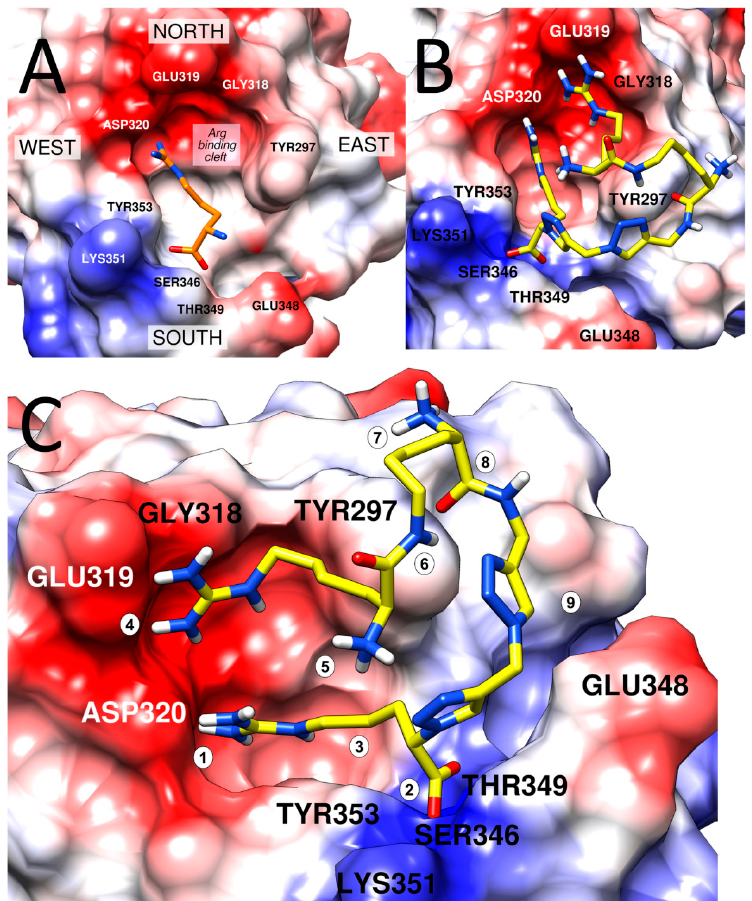
Figure 7. Binding site at the neuropilin-1. The protein is depicted as an electrostatic colour-coded surface (red: negative charges, white: neutral, blue: positive). ( A ) The binding site presented with the conventional assignment of directions as introduced in our previous contributions [28–30]. C-terminal arginine residue (orange, found in our inhibitors, but also in VEGF (4DEQ [44]) or tuftsin (2ORZ [43]) or arginine derivatives (5JGI, 5IYY, 5J1X, 5JGQ, 5JHK [45]) is shown in the cleft it occupies in crystal structures as well in simulations. ( B ) Compound 3 (yellow) at the NRP-1 binding site. A representative snapshot from SIM-I showing the discussed binding mode. Top projection. ( C ) Compound 3 (yellow) at the NRP-1 binding site. A representative snapshot from SIM-I showing the discussed binding mode. Rotated top projection. Marked are characteristic elements of the binding mode. 1—ionic interaction of Arg guanidine with Asp320; 2—hydrogen bonds of free carboxylate with Ser346 and Thr349; 3—Arg chain buried within the cleft, extended between Tyr353 and Tyr297, further apolar interactions with Trp301, Thr316, Gly414, Ile415, and Ser416; 4—Har interacts with Glu319 and Gly318; 5—Har free amine exposed to the solvent; 6—H of the amide bond interacts either with phenolic function of Tyr297 or forms an intramolecular hydrogen bond with triazole ring (N3); 7—Lys free amine exposed to the solvent; 8—carbonyl of the peptide bond forms an H-bond to the phenolic function of Tyr297; 9—C5H of the triazole ring is able to be involved in the H-bond with Glu348 depending on the rotameric state of this